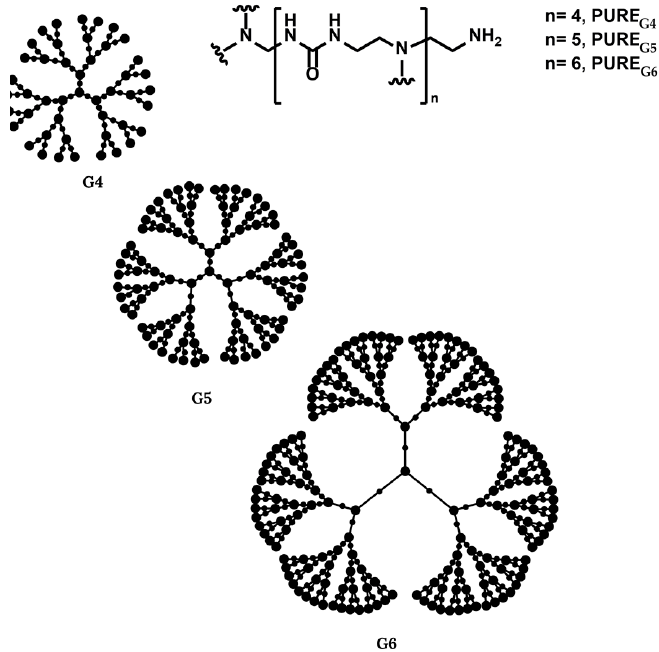
Figure 2 . Schematic representation of different polyurea (PURE) dendrimer generations used as drug and gene delivery nanocarriers. and gene delivery